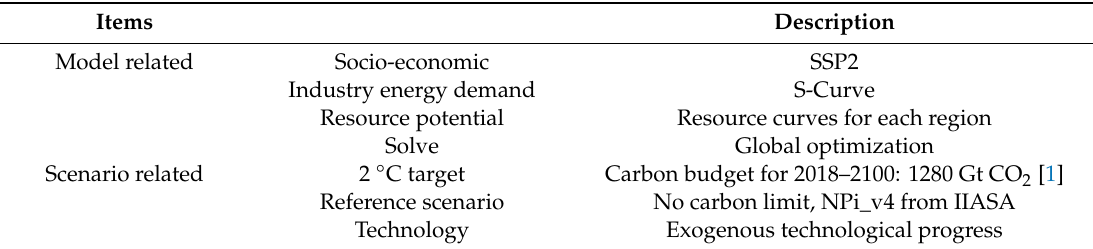
Table 3. Major boundary conditions and assumptions.